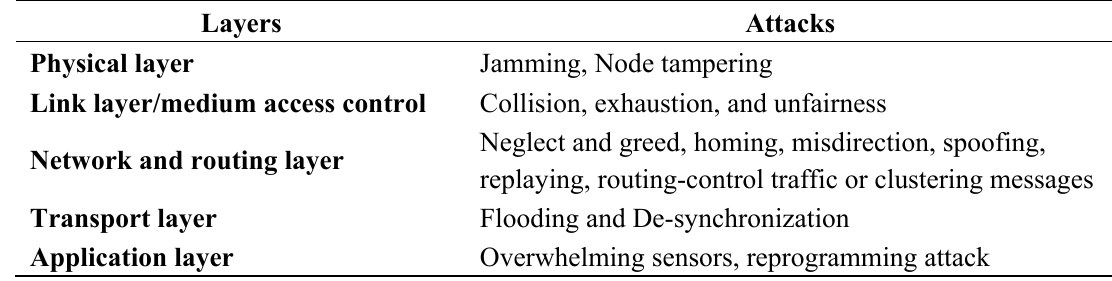
Table 2. Denial-of-service attacks at each network